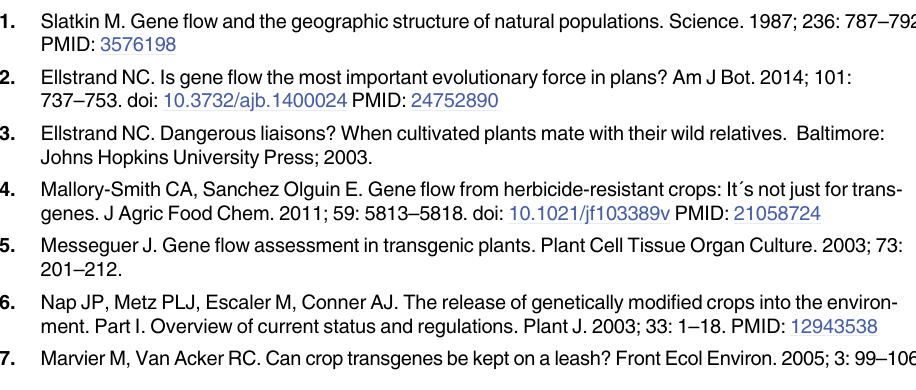
S1 Table. Chloroplast data. Plant and seedling ID (Sample Name), presence of the cp4 epsps transgene (GR), allele for the matK indel marker (matKdel), alleles for each of the 12 Agrostis chloroplast SSR markers (Acp_), and chloroplast haplotype